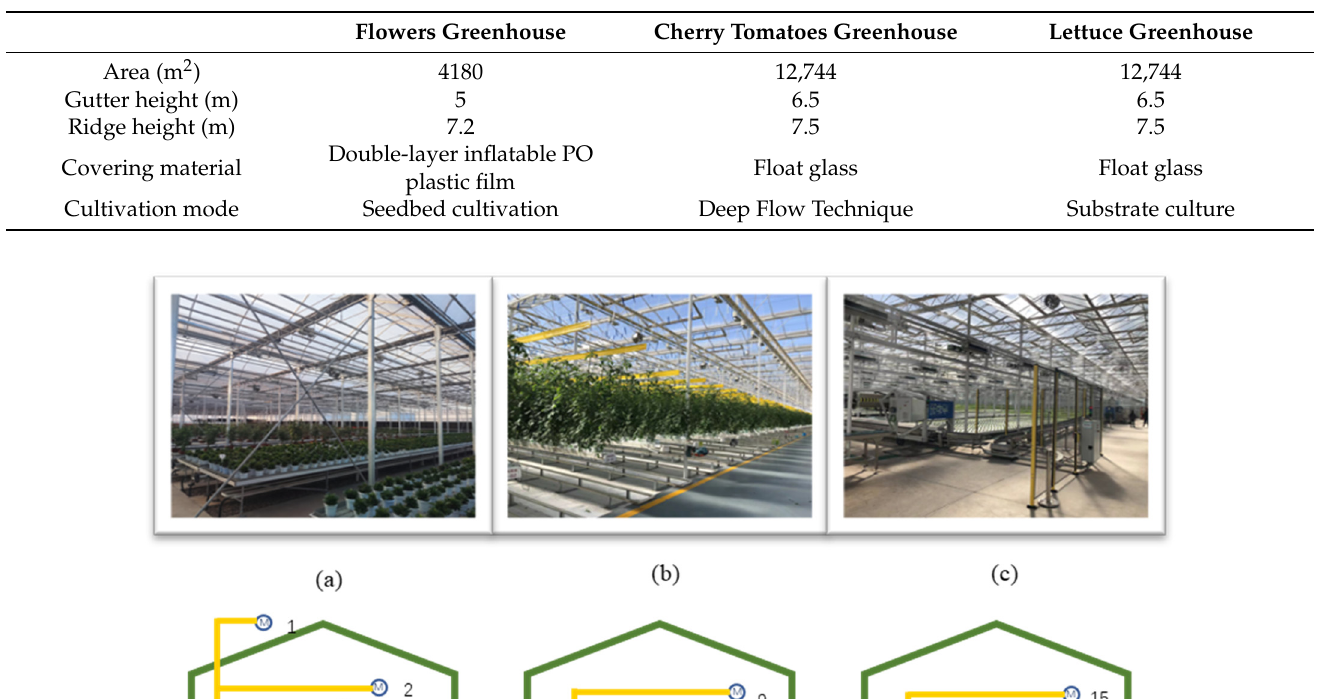
Table 1. Structure parameters of CEA buildings.